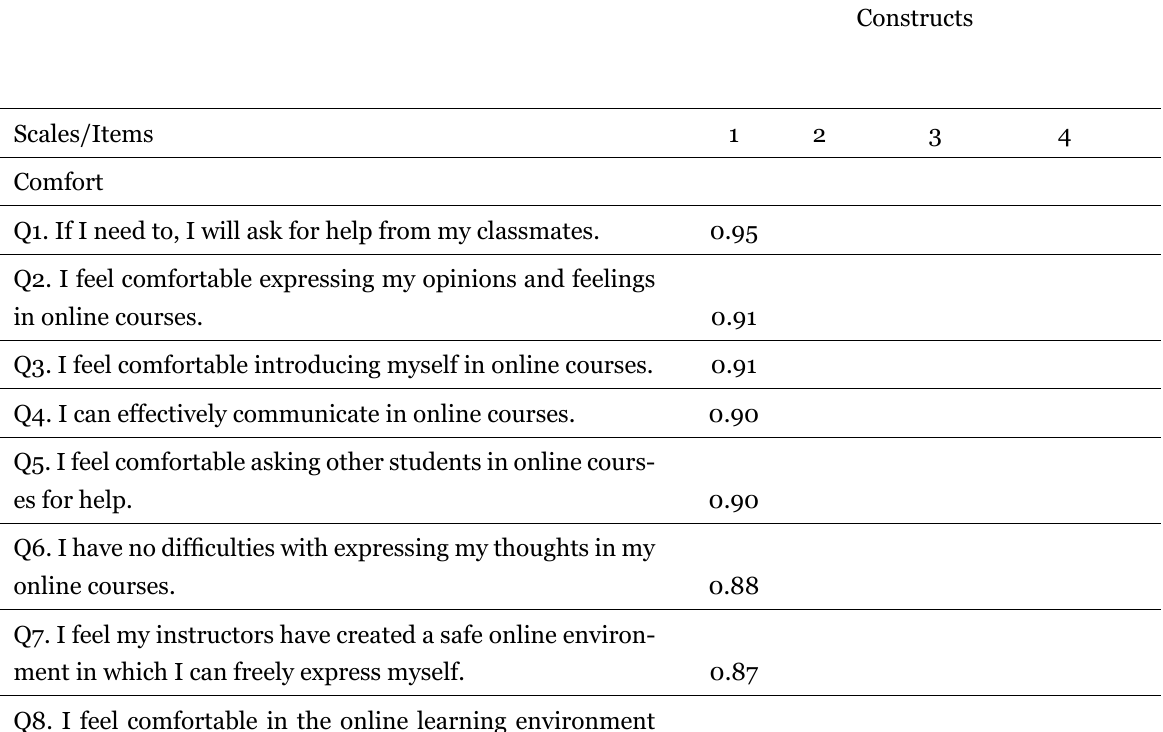
Table 1 Items, Factor Loadings, and Communalities (N = 146)